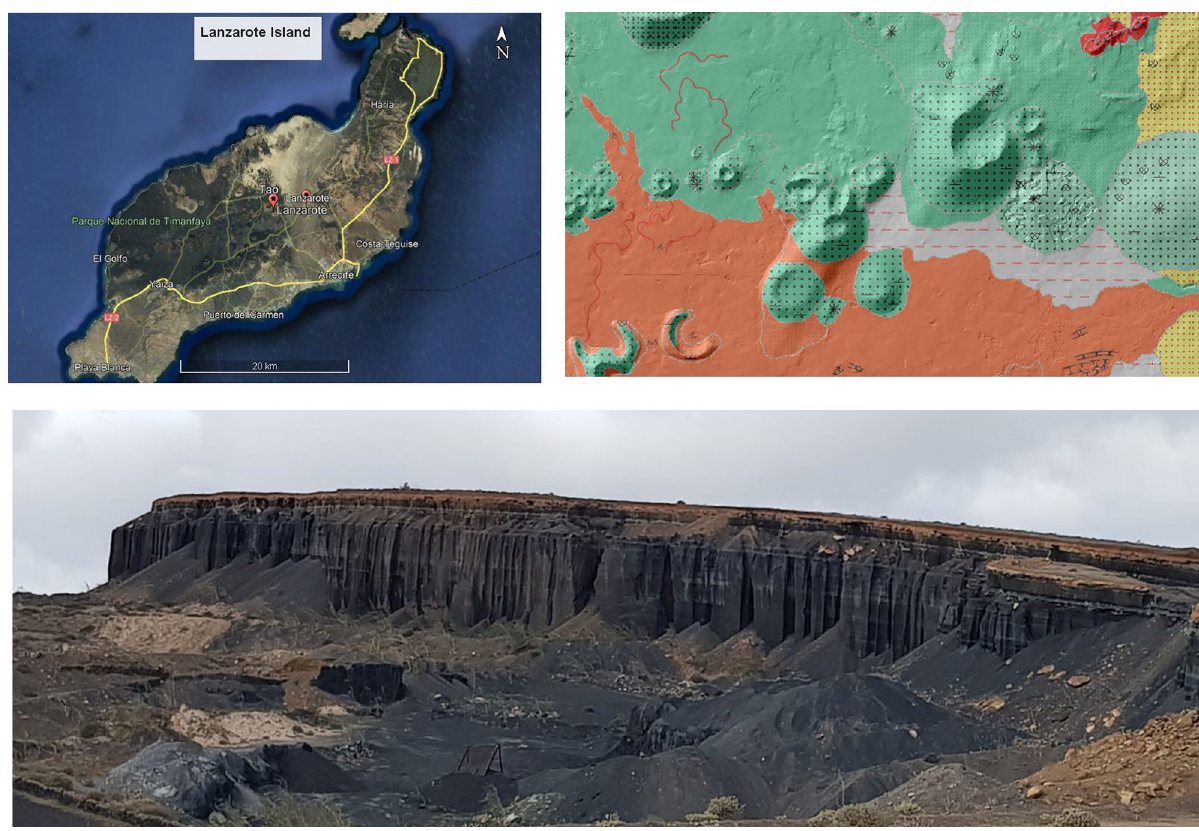
Figure 1. ( A ) Geographic map of Lanzarote (Canary Island) and position of the Tao sampling area. ( B ) Geological map of Tao. Green colours represent basaltic tephra cones and scattering pyroclasts. The red colours represent basalt and basalt olivine flows (Canary Islands Government. IDECanarias Visor 4.5.1. Available online: https:// visor. grafc an. es/ visor web/#). The yellow colours are sandy deposits and the grey sandy and clayey alluvial deposits. C) Tao